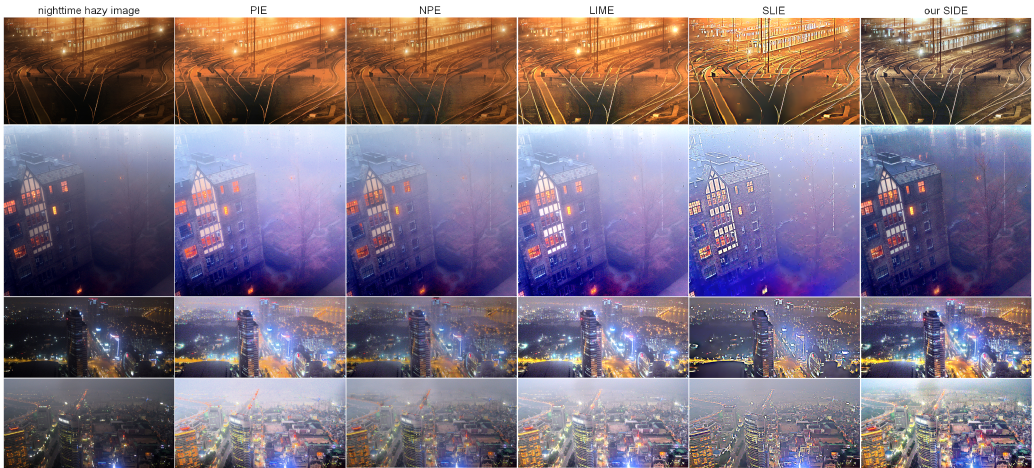
Figure 6. Comparisons of conventional low-light enhancement methods. From left to right: real nighttime hazy images, results of low-light enhancement methods PIE [51], NPE [49], LIME [17], SLIE [18] and the result of proposed SIDE.